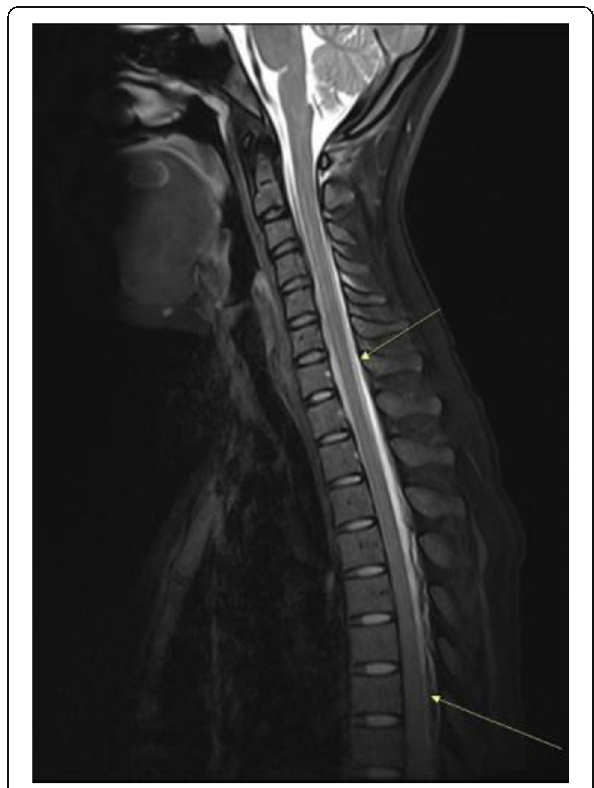
Fig. 2 (abstract P34). Spine MRI show diffuse fluid collection in the epi and subdural space, posterior to the C7-T7 cord.